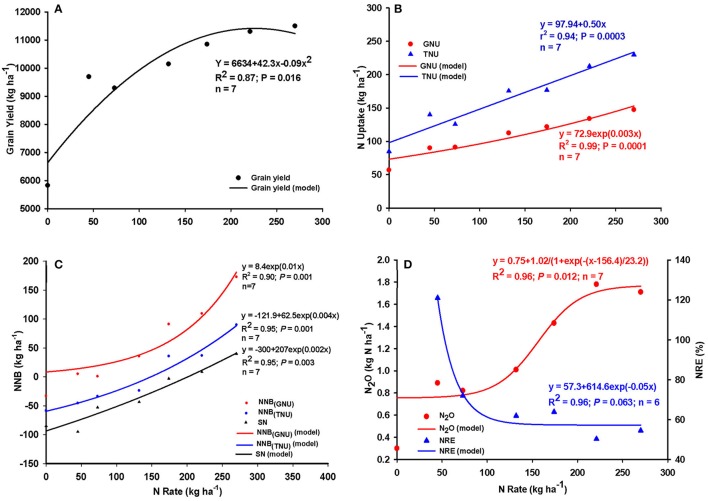
Relationship between N application rate and (A) maize grain yield (B) grain N (GNU) and total N uptake (TNU) (C) TNU, GNU, and surplus N (SN)-based net N balance (NNB), and (D) N recovery efficiency (NRE) and nitrous oxide emissions (N2O) across Colorado and Indiana (United States), and Quebec and Ontario (Canada) maize production systems. n = number of N rate groups, data points in x-axis represent mean value for the group.